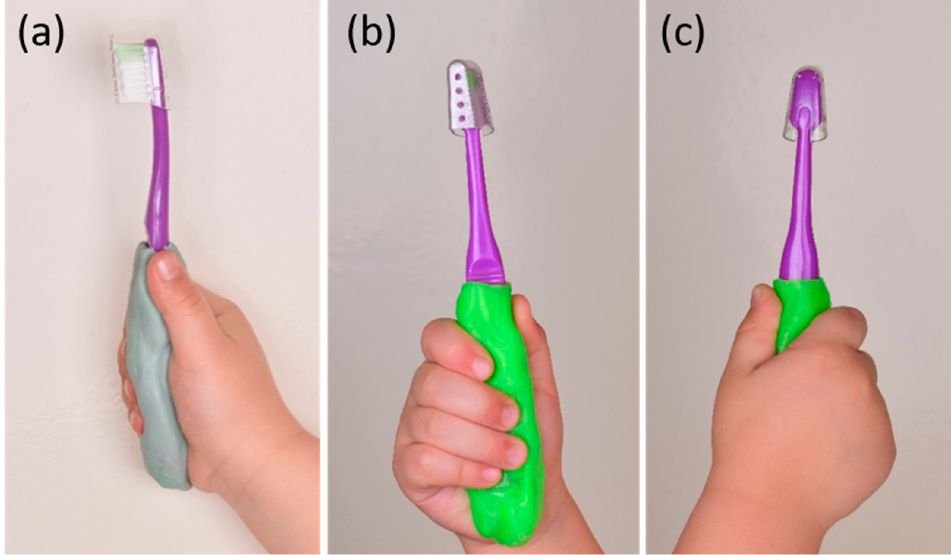
Figure 1. Fabrication of toothbrush handle: ( a ) Molding of participant’s hand condensation silicone; ( b , c ) Three-dimensional printed customized handle for toothbrush using Poly Lactic Acid material.